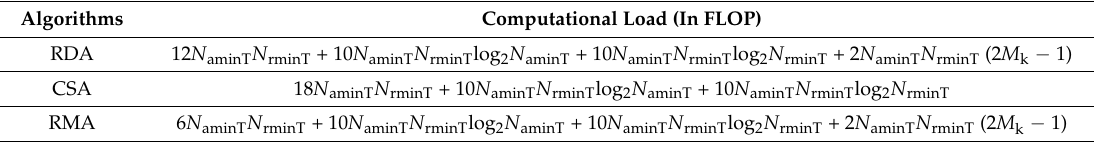
Table 3. Computational loads of classical imaging algorithms.